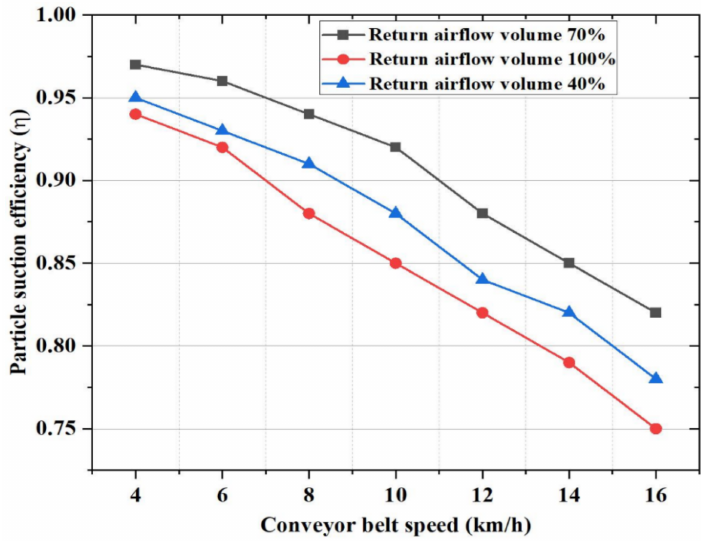
Figure 16. The speed dependence of particle suction